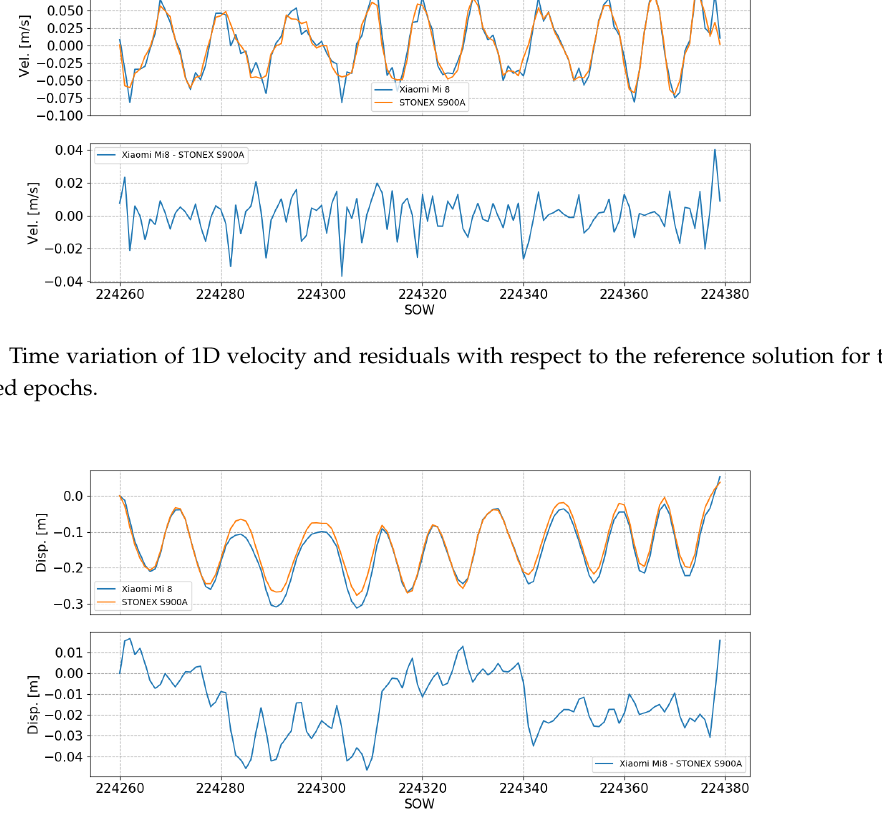
Figure 10. Time variation of 1D displacements and residuals with respect to the reference solution for the considered